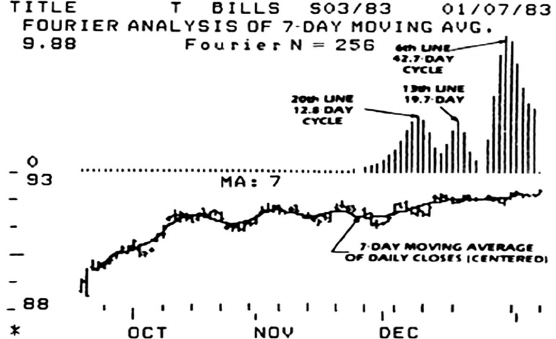
Fig. 3. Output of the spectral analysis program (Hutson 1983)